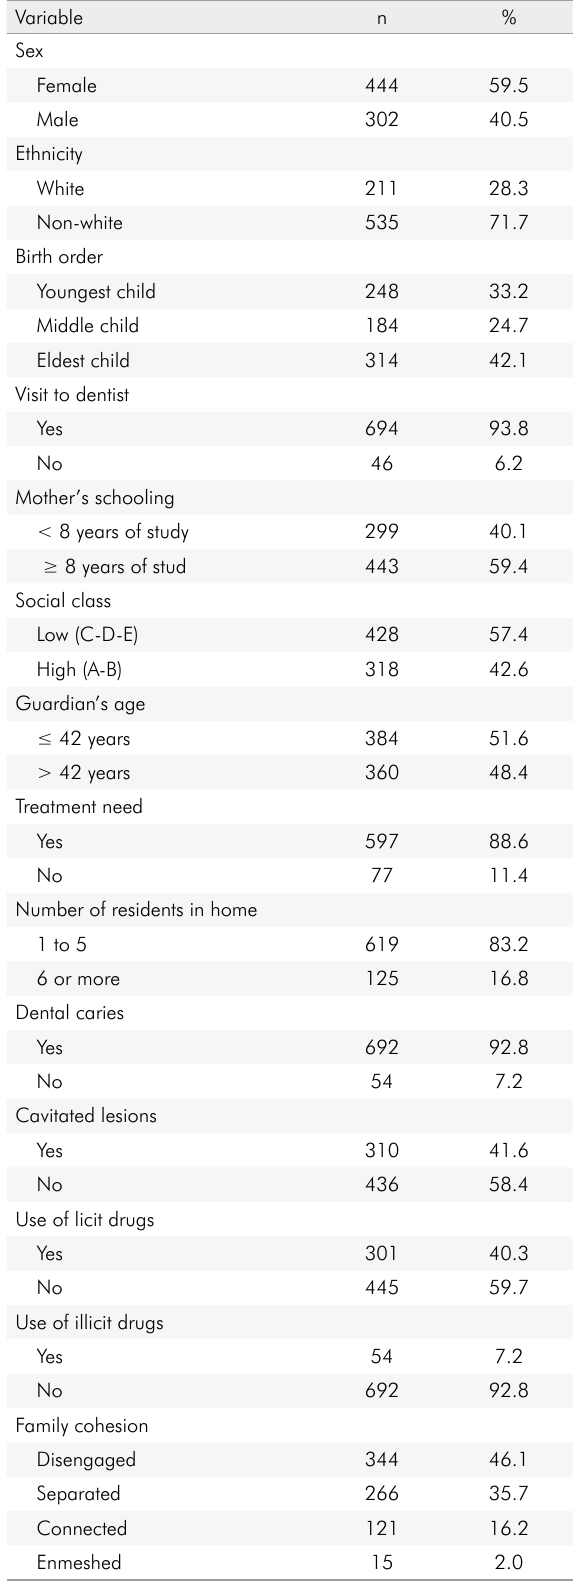
Table 1. Characterization of